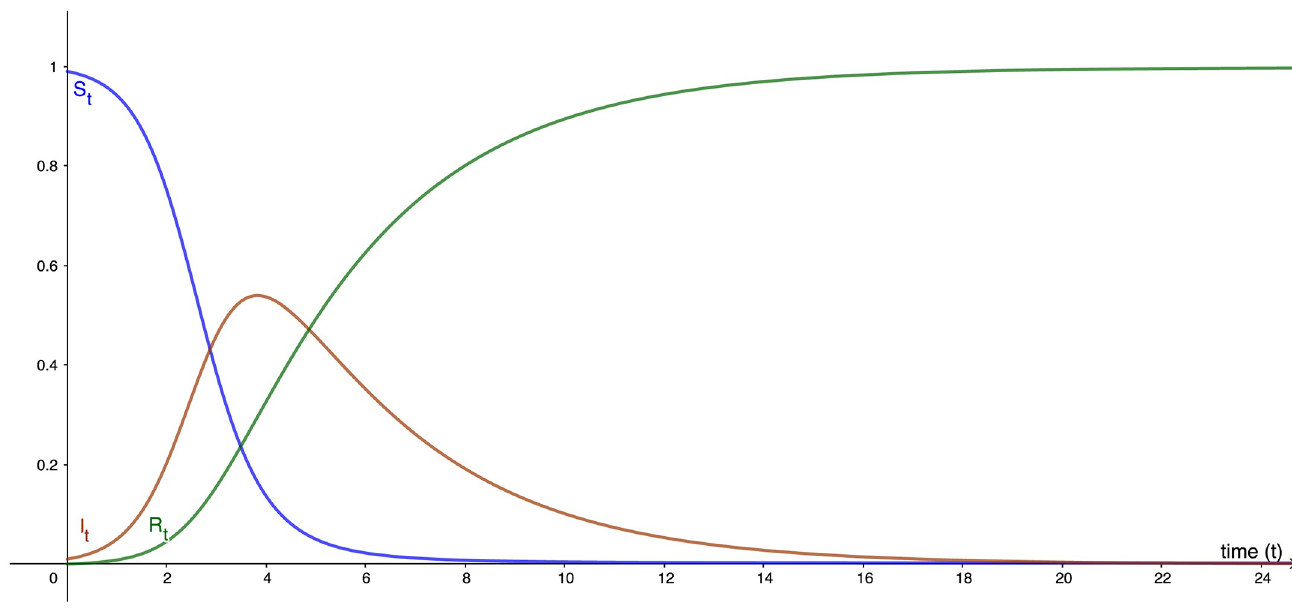
Fig 3. Dynamics of the SIR model.